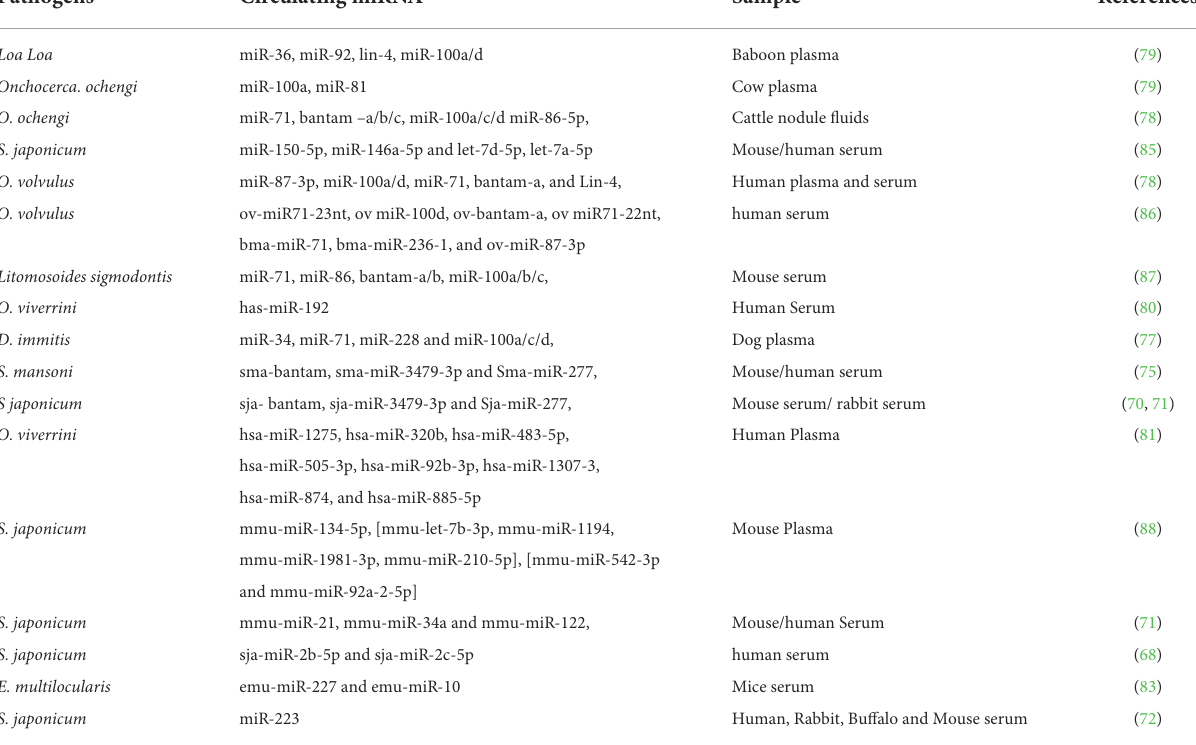
TABLE 1 Circulatory miRNAs detected from infected hosts. Pathogens Circulating